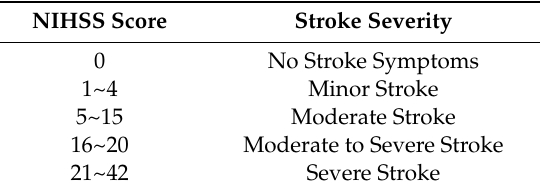
Table 7. Stroke severity class of NIHSS.